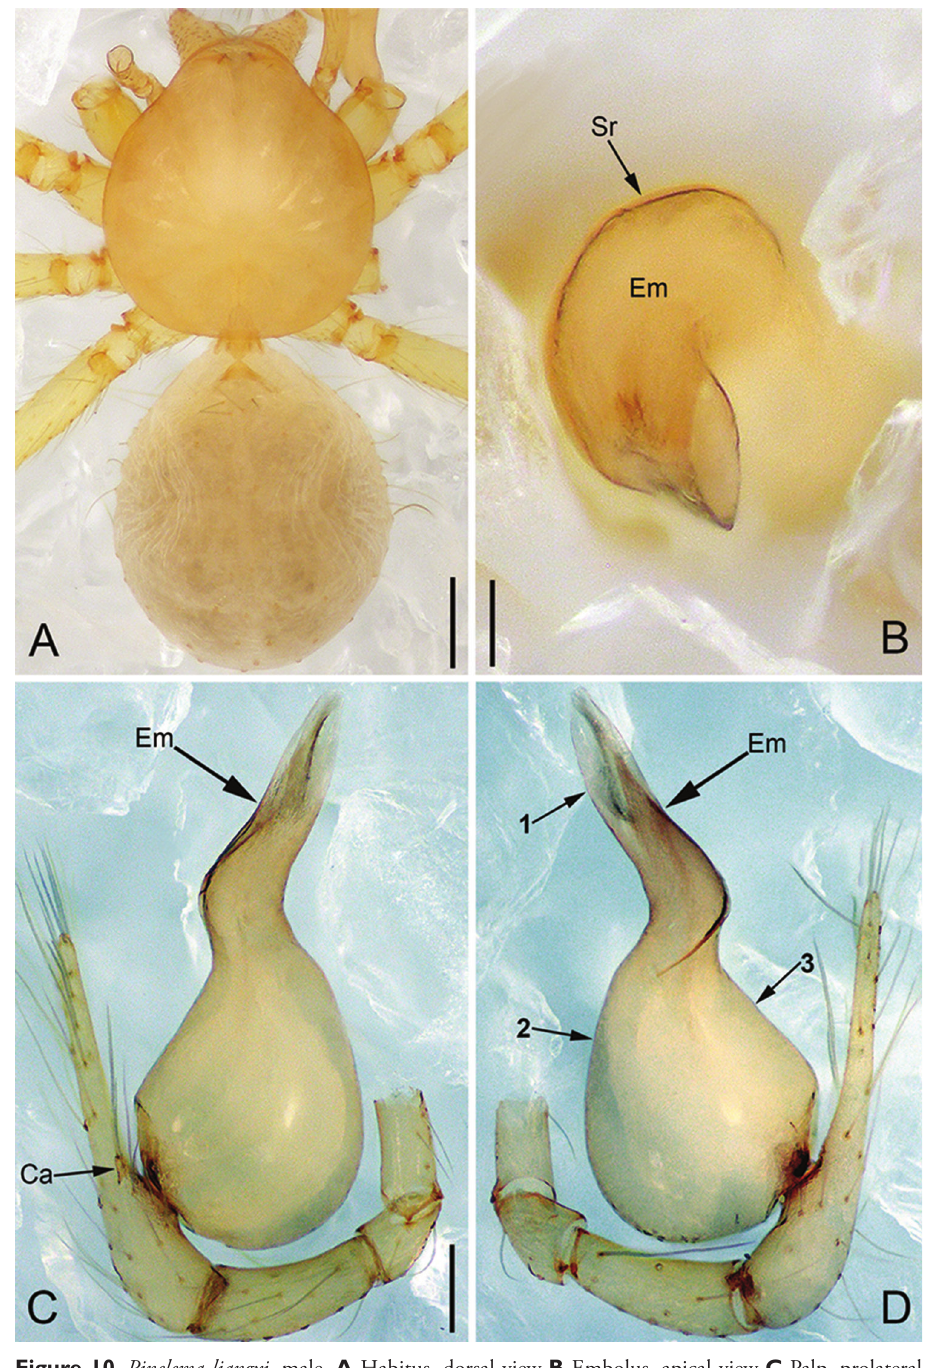
Figure 10. Pinelema liangxi , male. A Habitus, dorsal view B Embolus, apical view C Palp, prolateral view D Palp, retrolateral view. Scale bars: 0.2 mm ( A ), 0.05 mm ( B ), 0.1 mm ( C–D